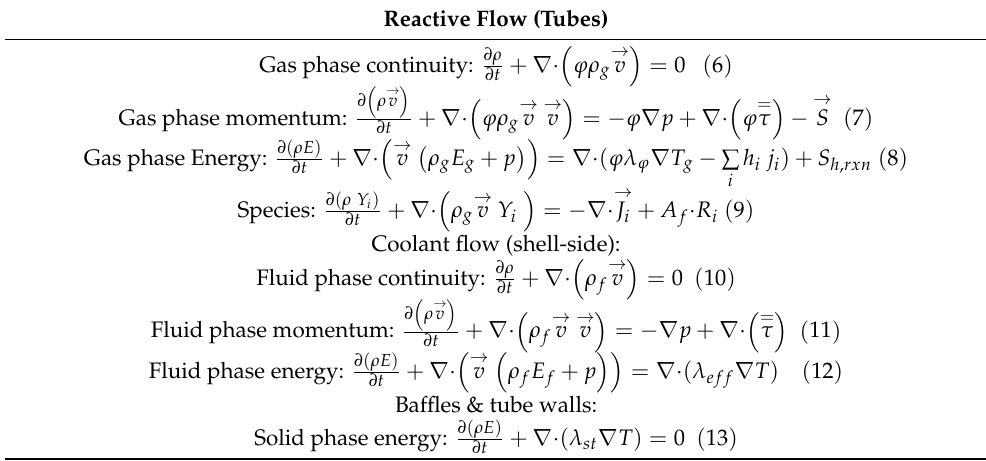
Table 3. Governing equations of the transient CFD